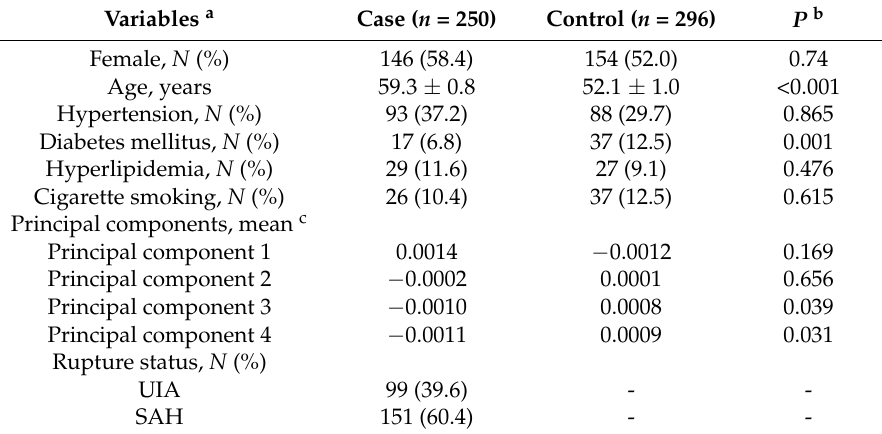
Table 1. Baseline Characteristics for Study Population.